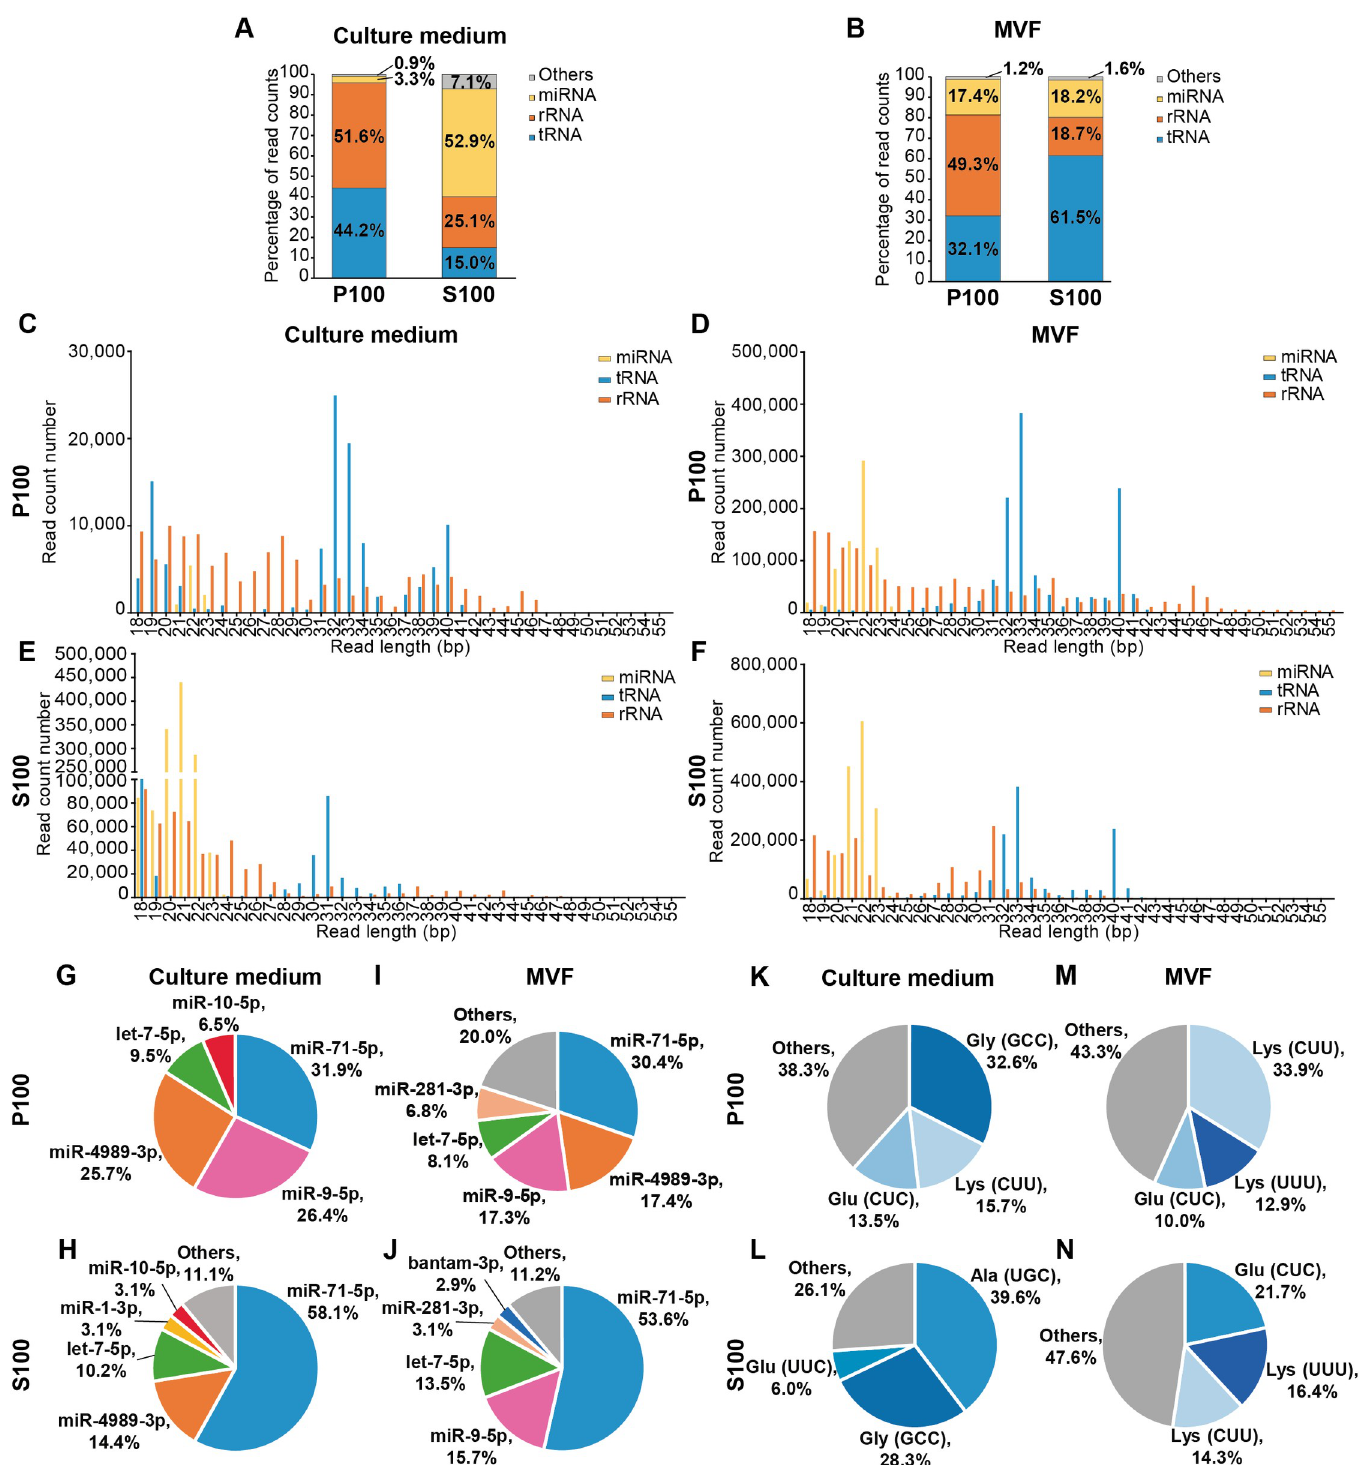
Fig 4. Ex-RNA profiling in P100 and S100 fractions from active metacestode cultures. RNA biotypes identified in culture medium (A) and metacestodes vesicular fluid (MVF) (B). Size distribution of miRNAs, tRNA-derived sequences and rRNA-derived sequences detected in culture medium (C, E) and MVF (D, F). Most abundantly detected miRNAs (G-J) and tRNA-derived sequences (K-N) from E . multilocularis .